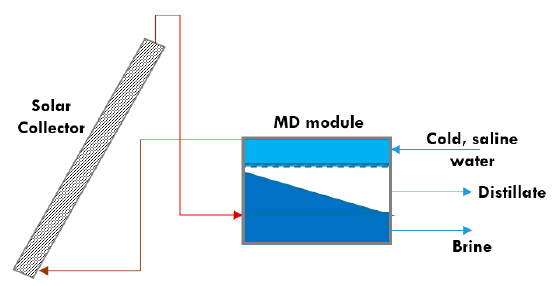
Figure 12. Flow schematic of a compact MD unit powered by solar collectors.